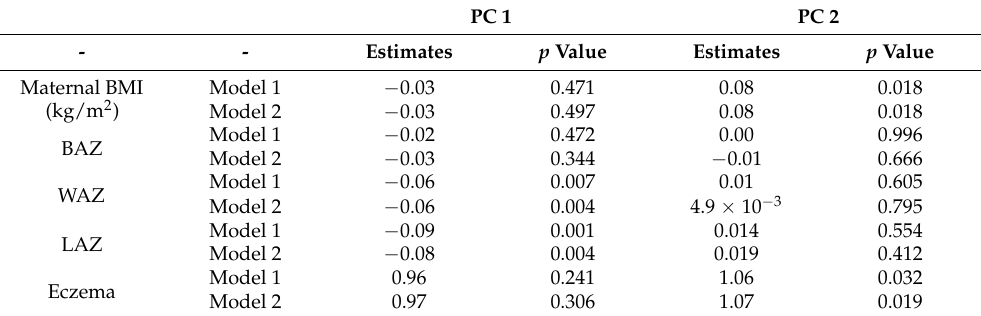
Table 2. Association between human milk PC scores, infant growth, and risk of eczema ( n = 200). PC 1 PC